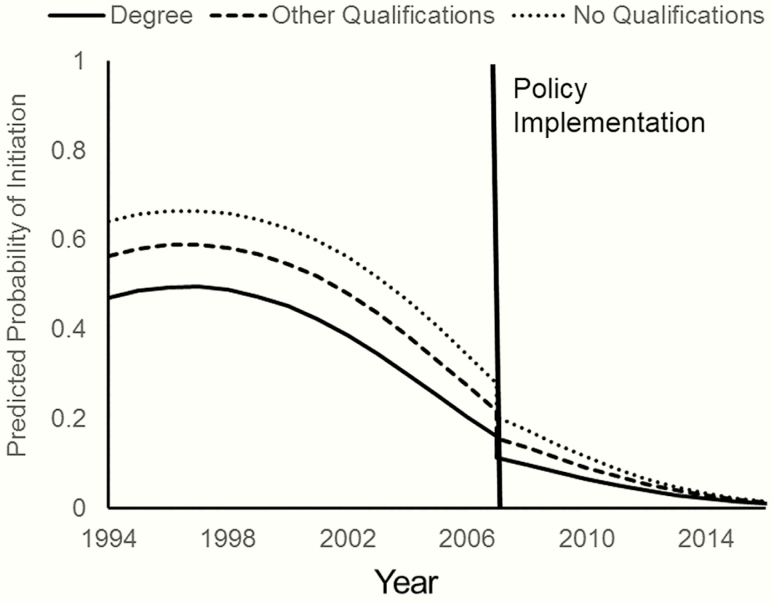
Effect of policy implementation on youth smoking initiation by parental education. Predicted probabilities are calculated based on the change in legal age models from Supplementary Table 3, for age 15 females in England, with e-cigarette prevalence at 0, and the tobacco excise duty rate held constant.